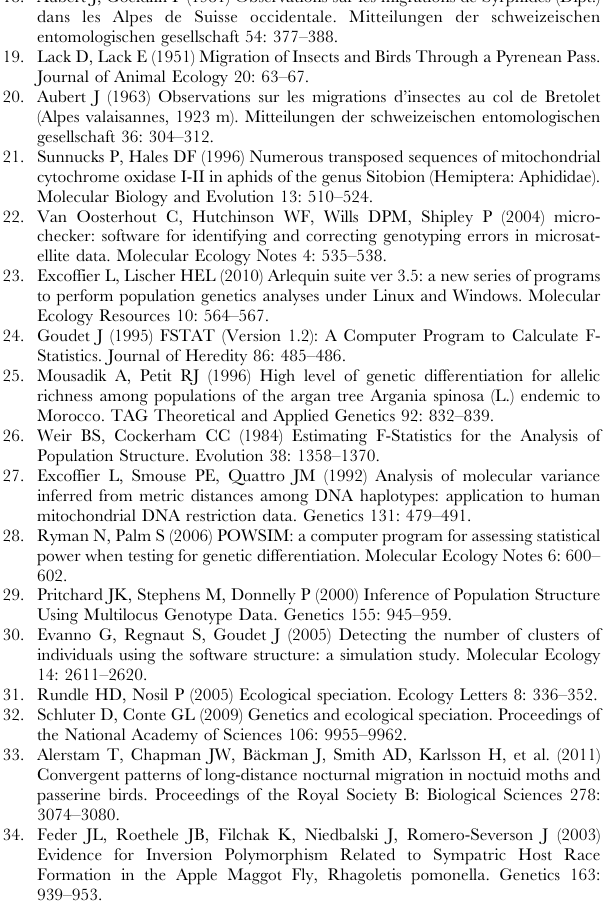
yses and are indicated in grey shading. Figure S2 Bayesian assignment probabilities for k = 2, K = 3 and K = 4. Each vertical line represents an individual, and colours indicate the proportion of an individual’s genotype assigned to a particular lineage, individuals are sorted by overwintering strategy and sampling